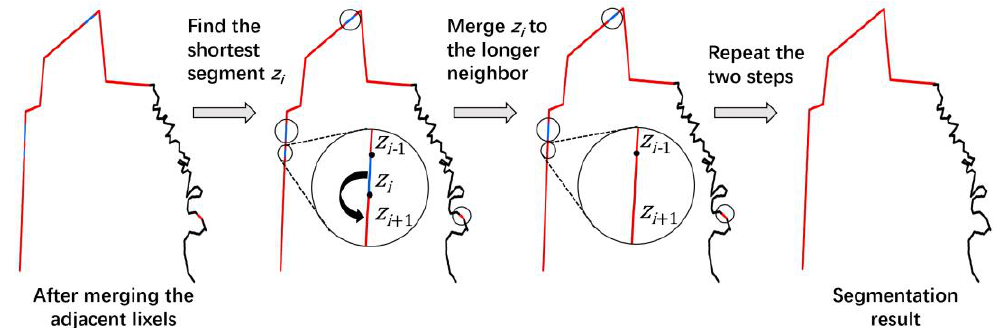
Figure 9. Post-processing for short segments to obtain fine segmentation results.